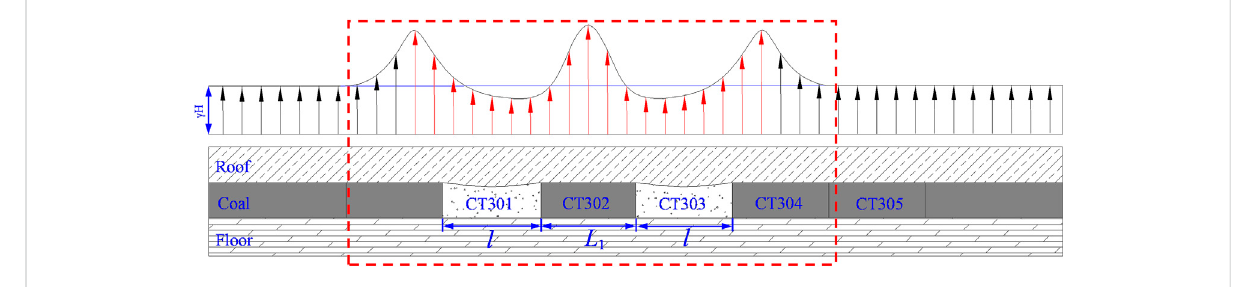
FIGURE 6 Structure 2 stress analysis diagram.